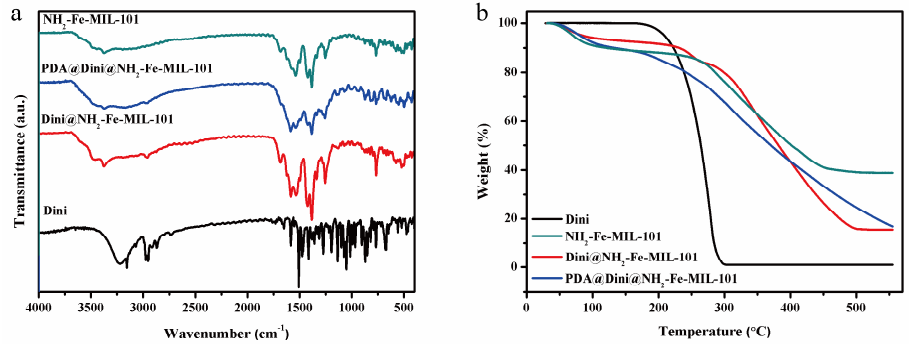
Figure 5. FTIR spectra ( a ) and TGA ( b ) of Dini, NH 2 -Fe-MIL-101, Dini@NH 2 -Fe-MIL-101 and